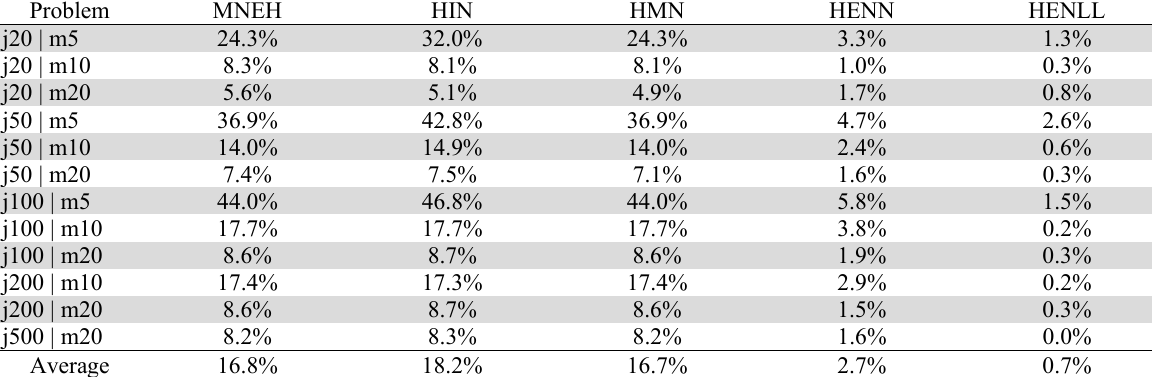
Relative deviation of heuristics with preventive maintenance policy 1